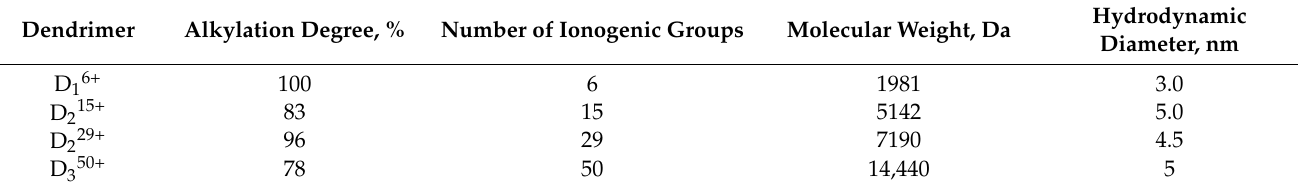
Table 2. Characterization of pyridylphenylene dendrimers.